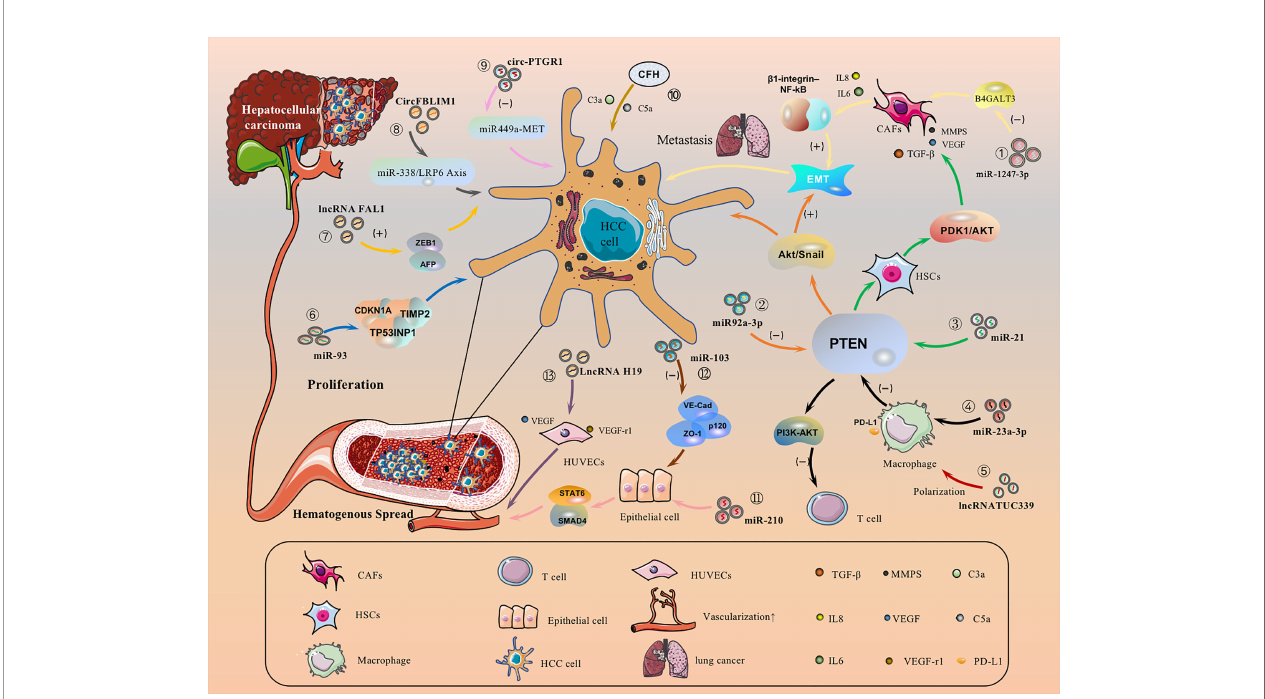
FIGURE 3 | HCC cell-derived EVs carry cargo and regulate different receptor